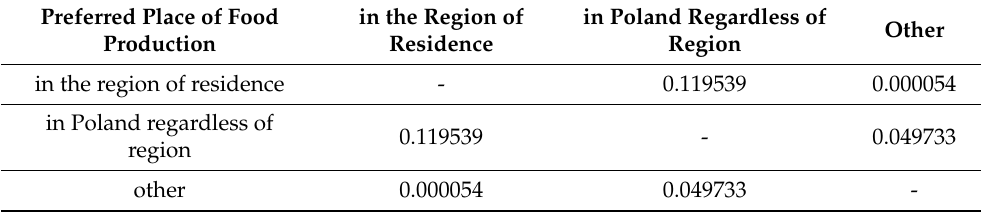
Table 3. Altruism level—Dunn’s test results.